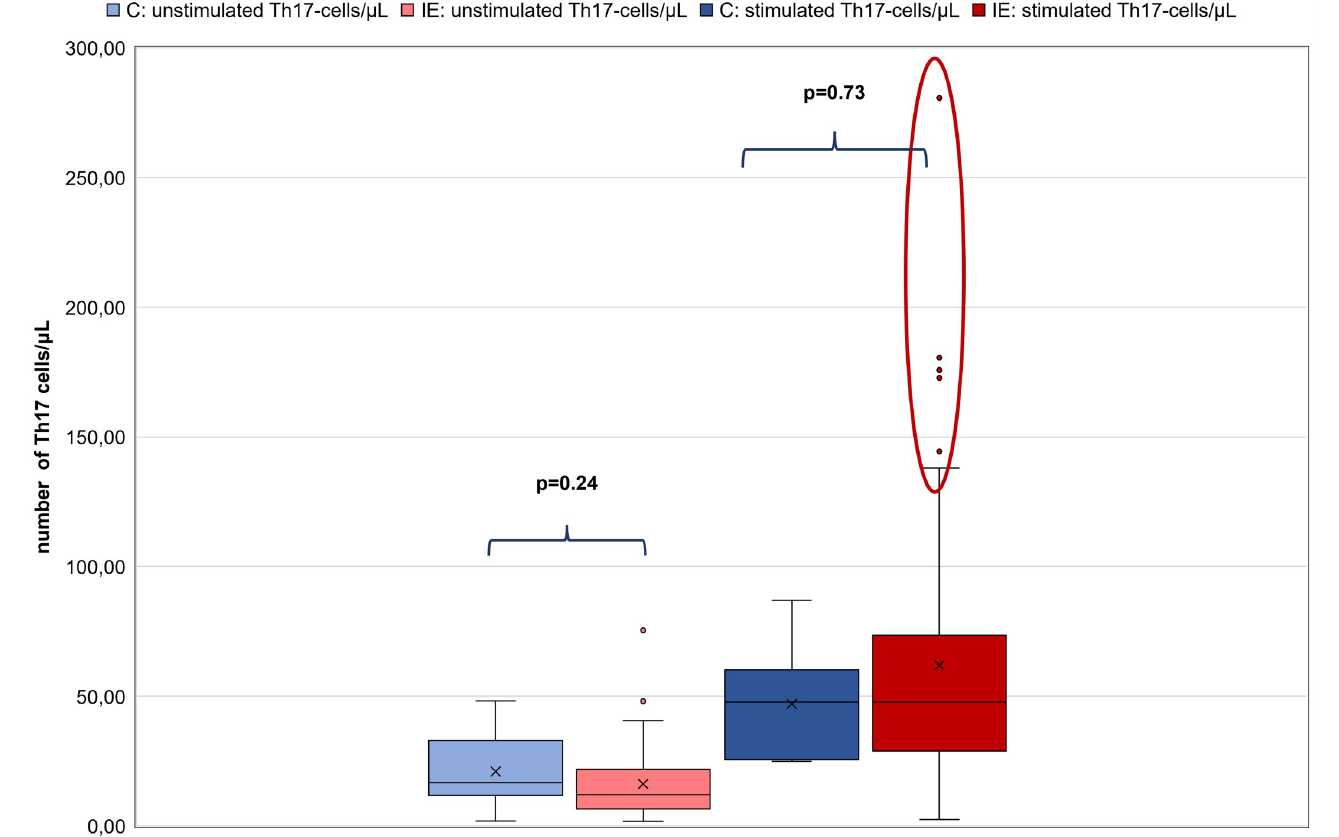
Fig 1. Comparison of the control group with dogs with IE regarding their amount of Th17 cells/ μ L. Left pale blue box plot showing results of unstimulated Th17 cells/ μ L of the control group (C) (n = 10) and the second pale red box plot showing results of unstimulated Th17 cells/ μ L of dogs with IE (n = 57). The third dark blue box plot showing results of stimulated Th17 cells/ μ L of C (n = 10) and the fourth dark red box plot showing results of stimulated Th17 cells/ μ L of dogs with IE (n = 57). All box plots represent the maximum, the third quartile, the mean, the median, the first quartile and minimum of the measured Th17 cells/ μ L. Dots represent outliers. There is no significant difference between the dogs of C in comparison to the dogs with IE regarding their amount of unstimulated as well as stimulated Th17 cells/ μ L (p = 0.24; p = 0.73, respectively). But analysis demonstrates that there are some outliers (demonstrated within the red circle) in the population of dogs with IE with strongly increased numbers of Th17 cells/ μ L. Abbreviations: C: control group; IE: idiopathic